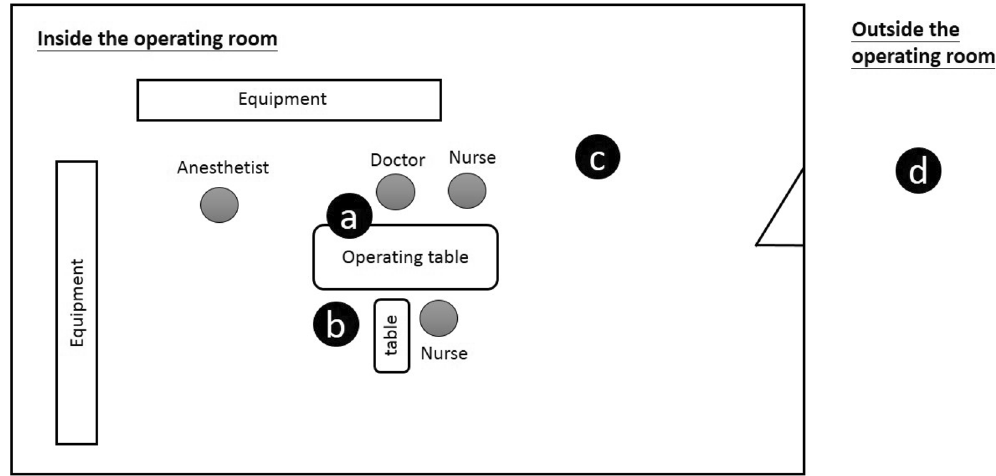
Figure 2. Schematic of the sampling locations in the OR. ( a ) The main knife range; ( b ) outside the operating table; ( c ) background; ( d ) outside the operating